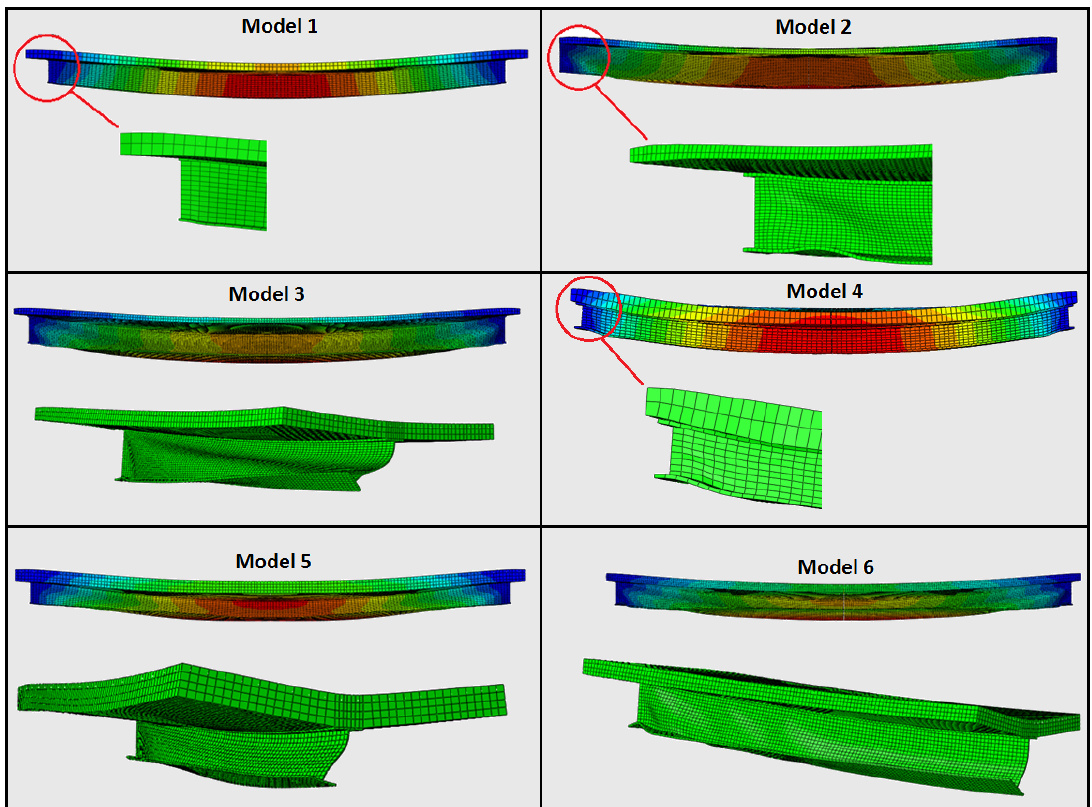
Figure 16. Deformation results for the semi-continuous case at